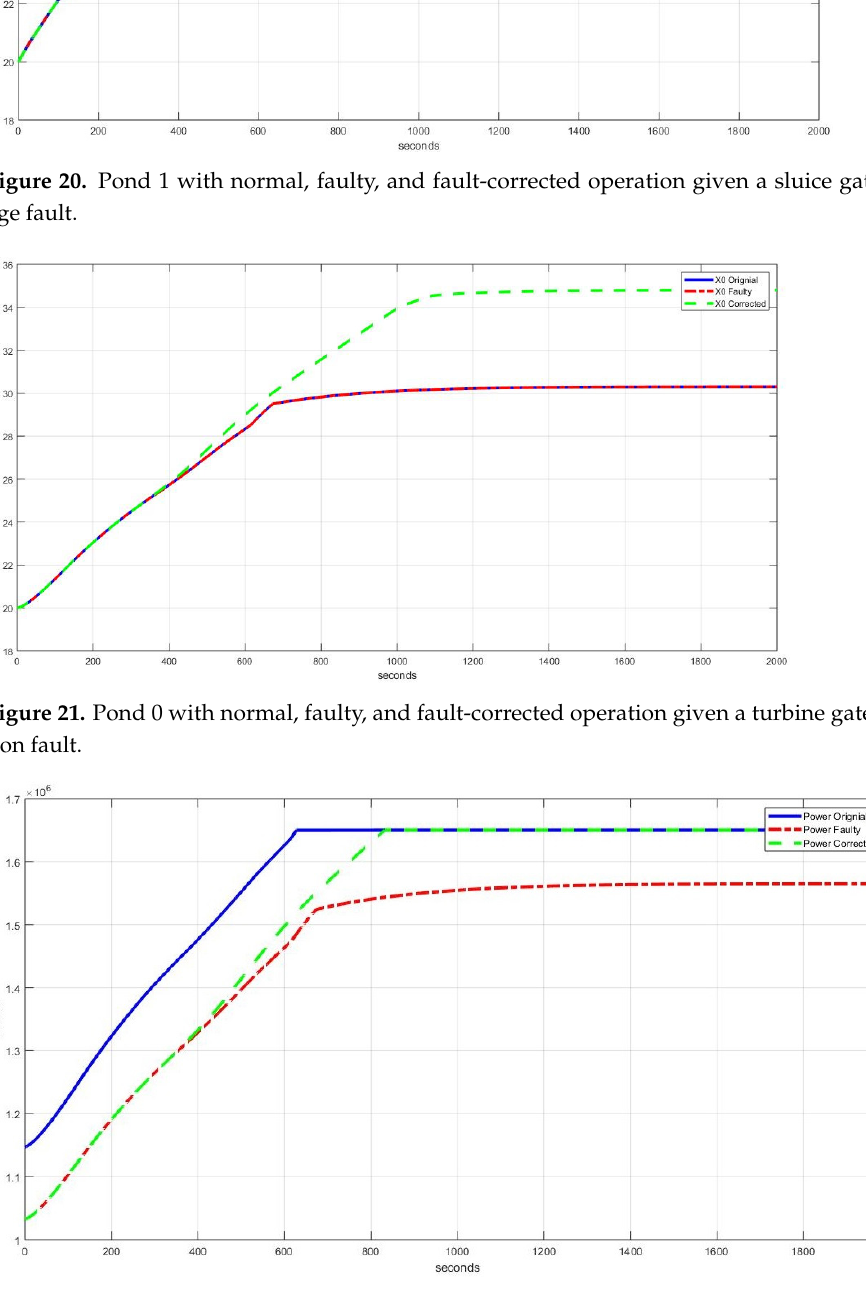
Figure 22. Power with normal, faulty, and fault-corrected operation given a turbine gate 𝐺 satu- ration fault.